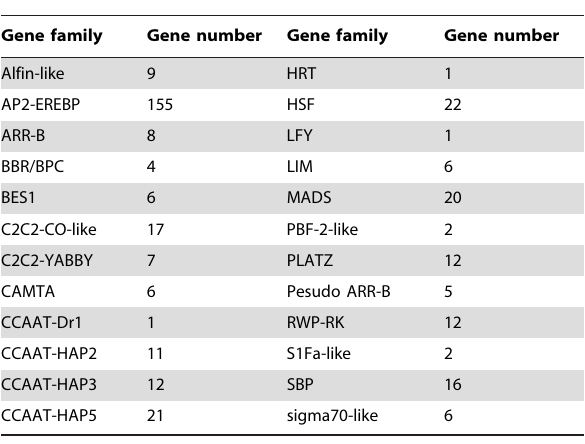
Table 2. Transcription factor families for Ecotilling.